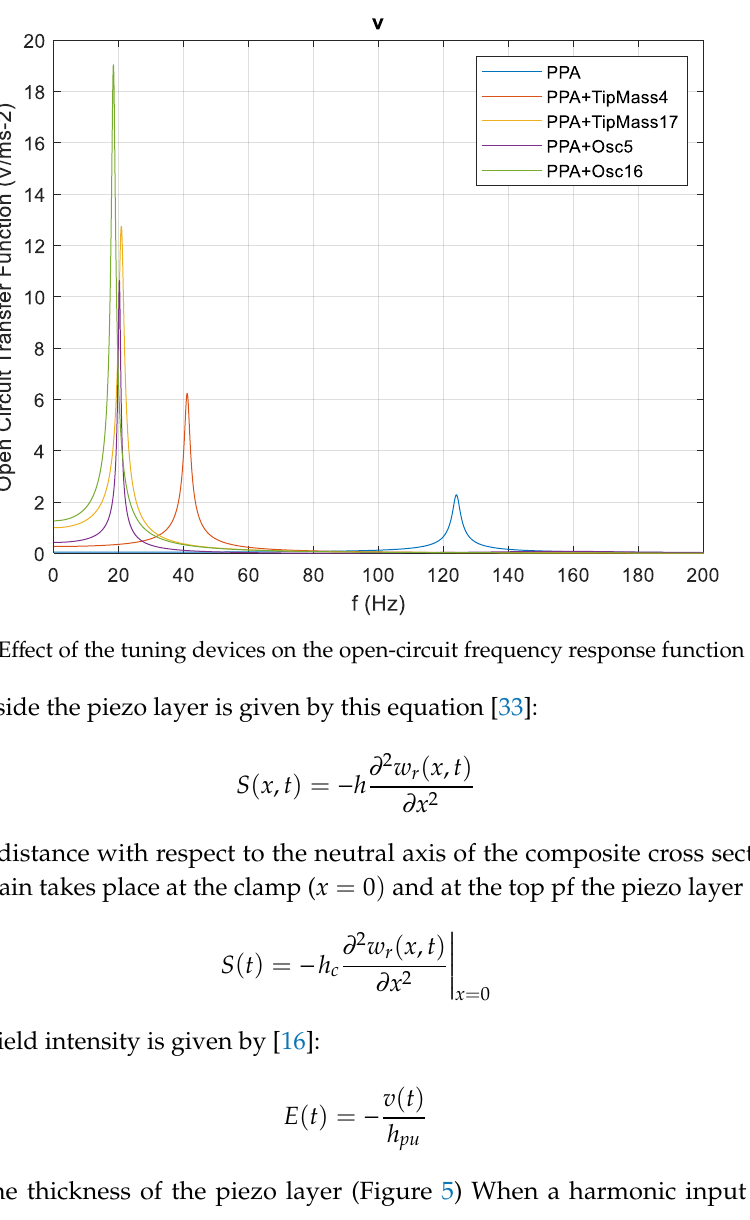
10 of 19 Figure 6. Scheme of the oscillators. ( a ) stiff high–mass oscillator A. ( b ) compliant low–mass oscillator B. Table 2. Characteristics of oscillators. Oscillator A